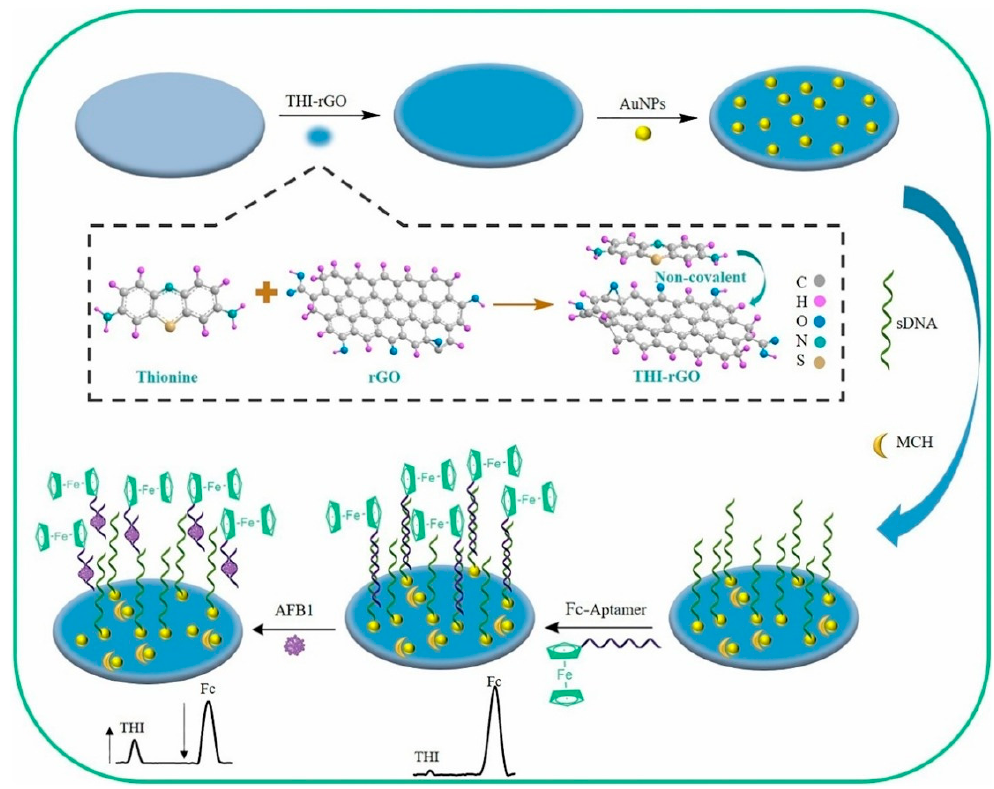
Figure 9. Schematic illustration of the fabrication of the AFB1 aptasensor. Reproduced from [73]. Copyright 2019 Elsevier.